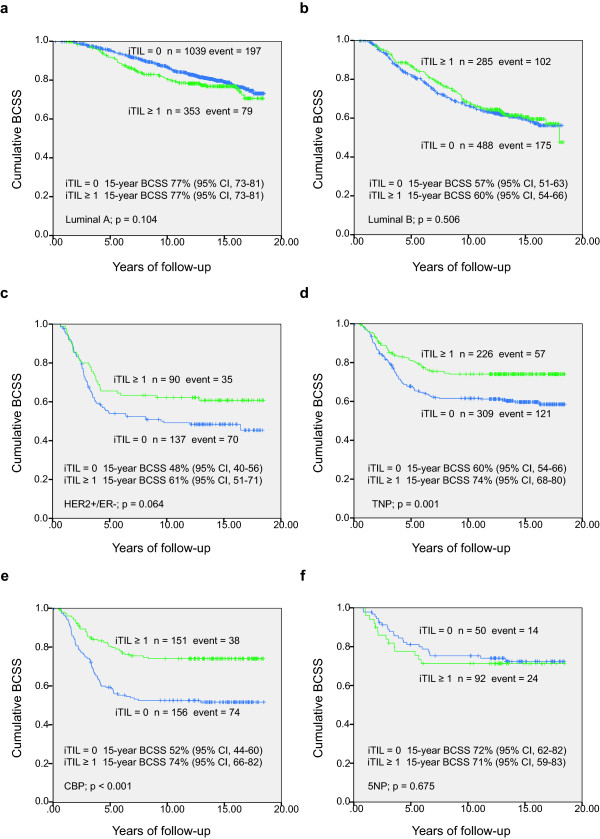
Breast cancer-specific survival (BCSS) by intratumoral tumor-infiltrating lymphocytes (iTILs) in different breast cancer intrinsic subgroups. (a) Luminal A, (b) luminal B, (c) HER2+/ER-, (d) triple-negative phenotype, (e) core basal phenotype, and (f) five negative phenotype subgroups. CI, confidence interval; ER, estrogen receptor; HER2, human epidermal growth factor receptor-2.